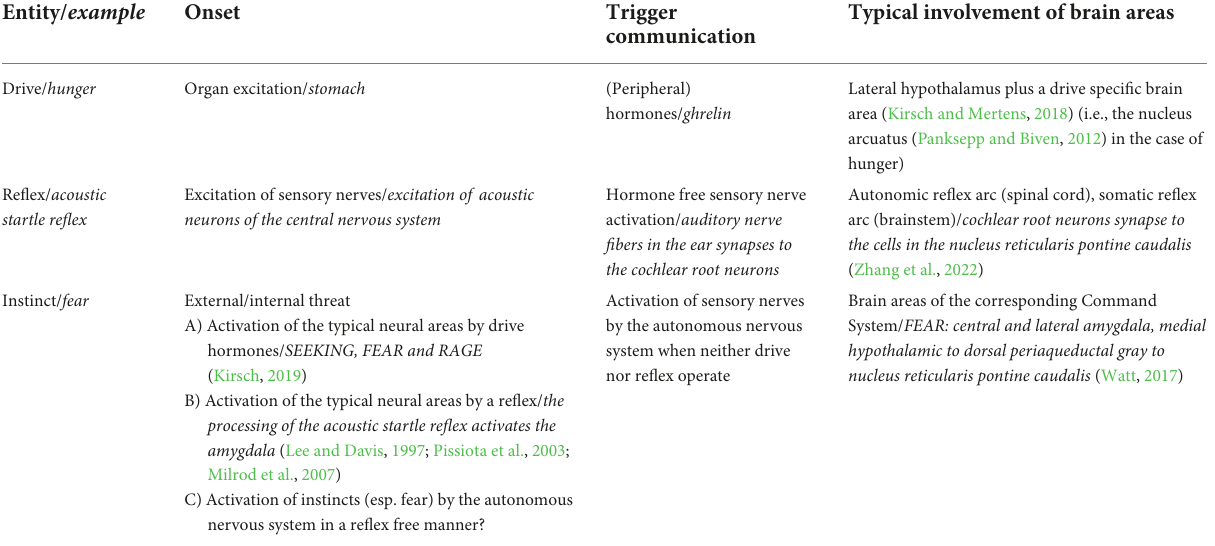
TABLE 3 Principal differences between drives, reflexes and